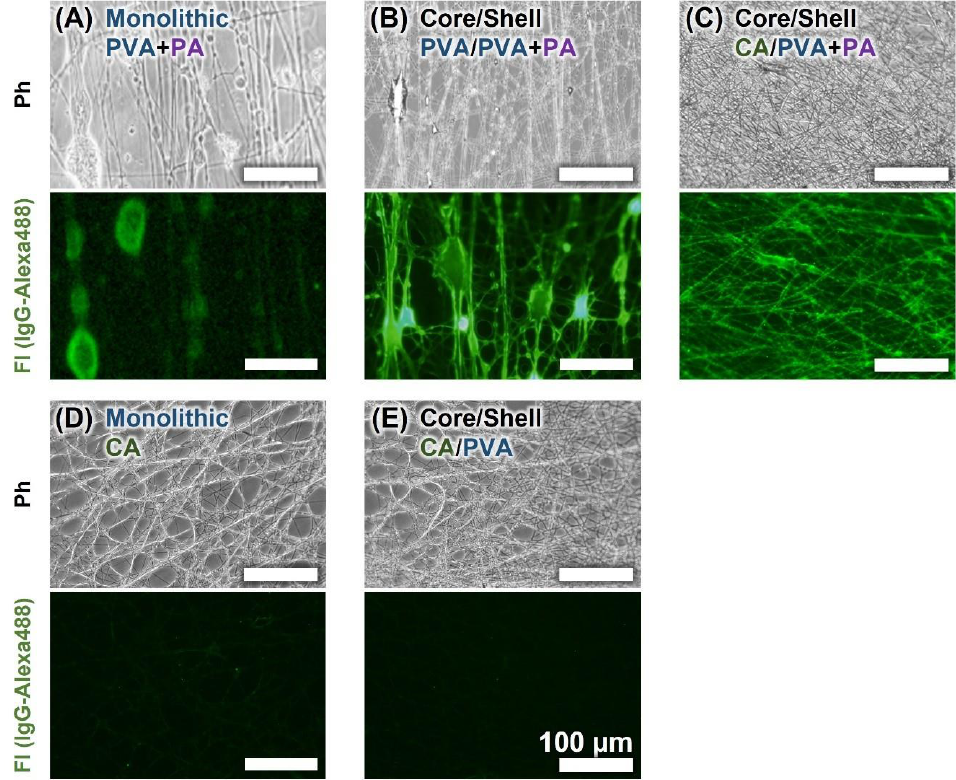
Figure 3. Fluorescent microscopy of fabricated NF treated with fluorescence-labeled antibody. ( A ) Monolithic PVA + PA. ( B ) Core-shell PVA/PVA + PA NF. ( C ) Core-shell CA/PVA + PA NF. ( D ) Monolithic CA. ( E ) Core-shell CA/PVA NF without the immobilization of PA.